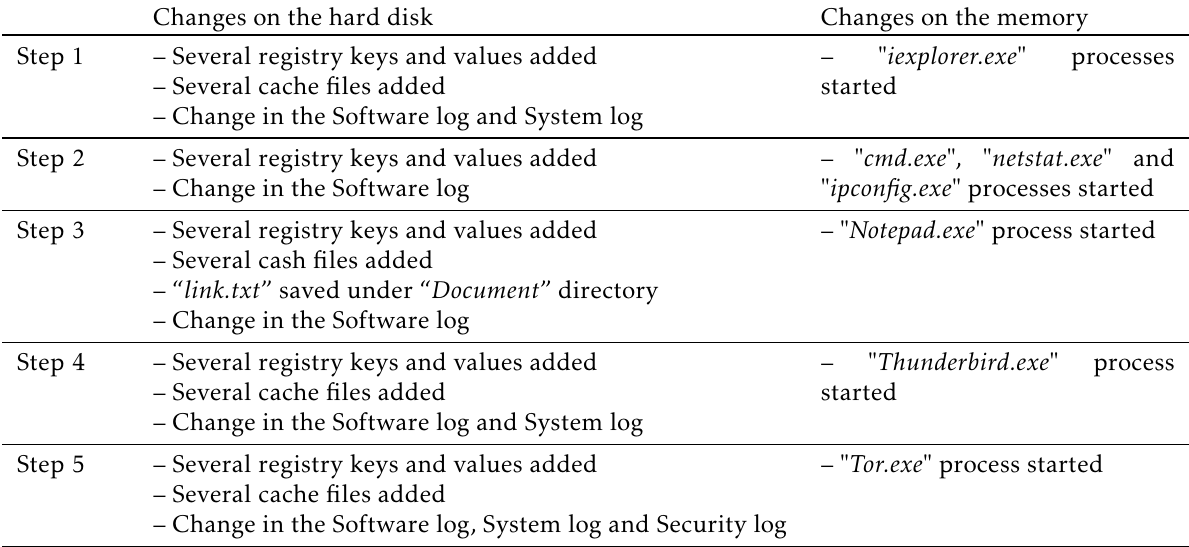
Table 5. System changes from generating user data in the experiment setup within ToolWiz Time Freeze